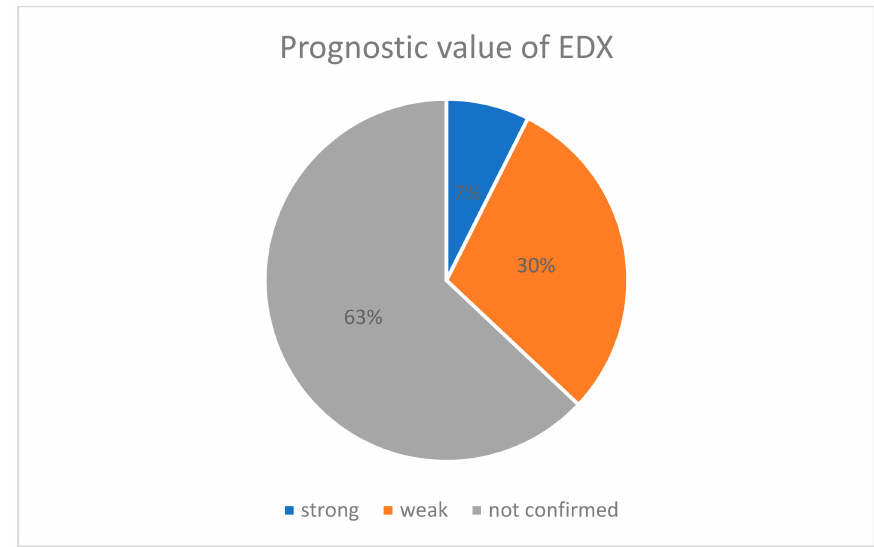
Figure 2. Percentage pie chart presenting prognostic value of